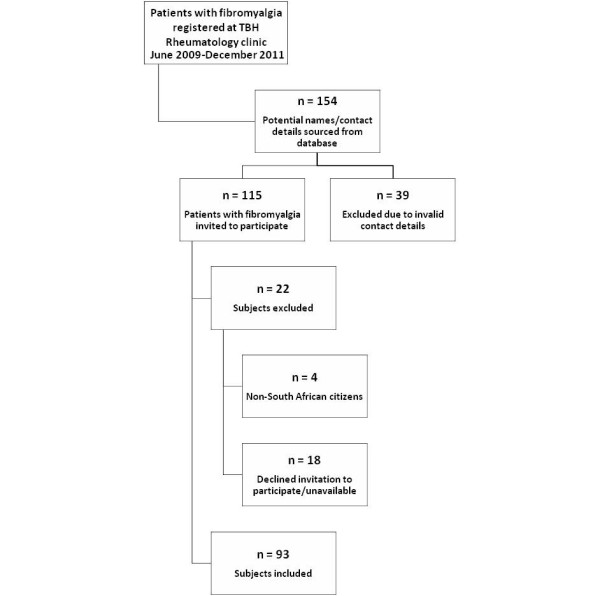
Flow diagram depicting subject inclusion and exclusion process.